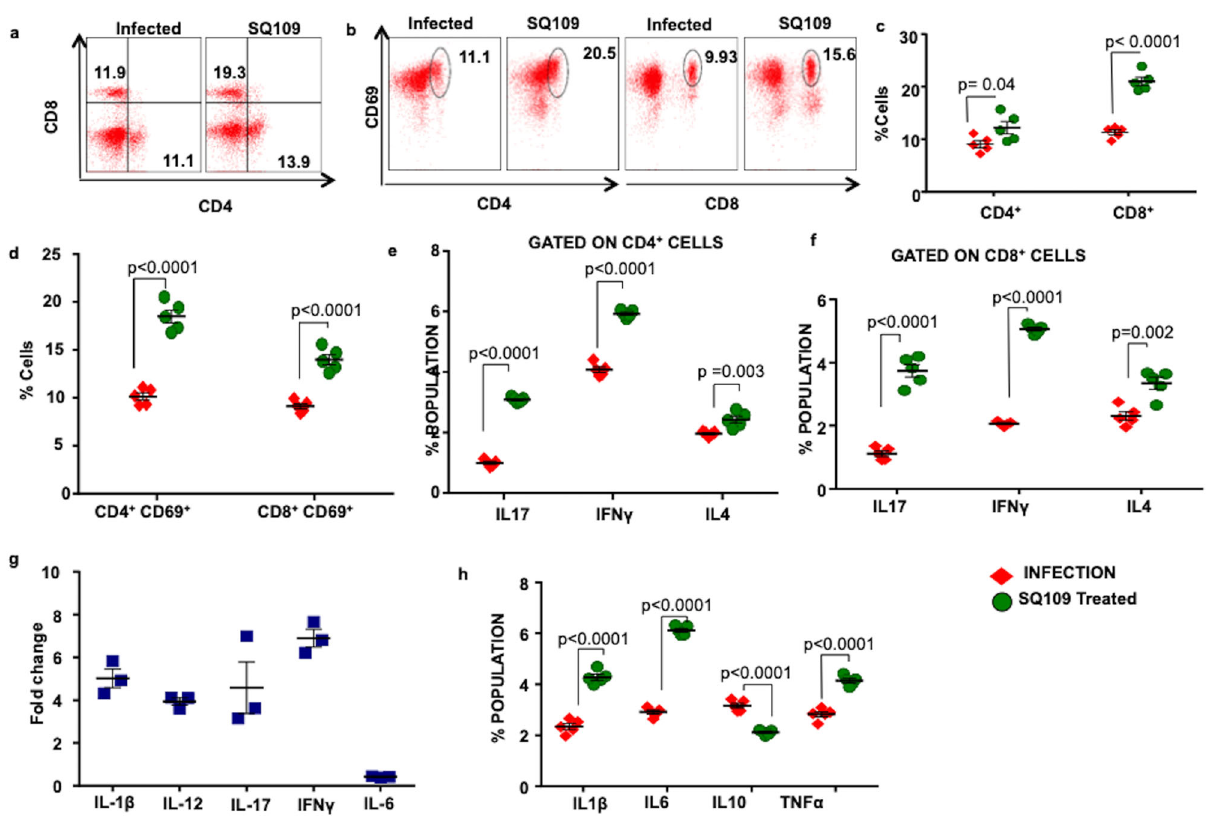
Fig. 2 SQ109 treatment induces protective immunity against M.tb . a , c FACS data to show the percentage of CD4 + and CD8 + T cells in the spleen of different groups of mice infected with the H37Rv strain of M.tb and treated with SQ109. b , d Activation pro fi le of T cells (CD4 + and CD8 + ) in spleen of mice infected with H37Rv and treated with SQ109. e Cytokine pro fi le (IFN- γ , IL-17, and IL-4) of CD4 + T cells in the spleen of different groups of mice infected with H37Rv and treated with SQ109. f Cytokine pro fi le (IFN- γ , IL-17 and IL-4) of CD8 + T cells in the spleen of different groups of mice infected with H37Rv and treated with SQ109. g RT-PCR data to show expression of cytokines at the transcriptional level in the lungs of different groups of mice infected with H37Rv and treated with SQ109. h Pro fi ling of intracellular cytokines (IL-1 β , IL-6, IL-10 and TNF- α ) in splenocytes of different groups of mice infected with H37Rv and treated with SQ109. Data shown here are representative of two independent experiments with 5 mice in each group. Statistical signi fi cance was determined using multiple t -test. n = 5 biological replicates were used for two independent